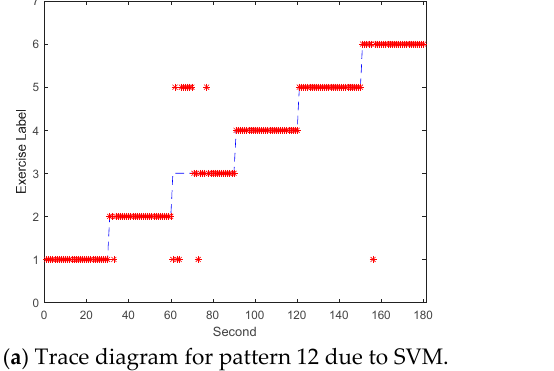
( a ) Uploading exercise datasets.